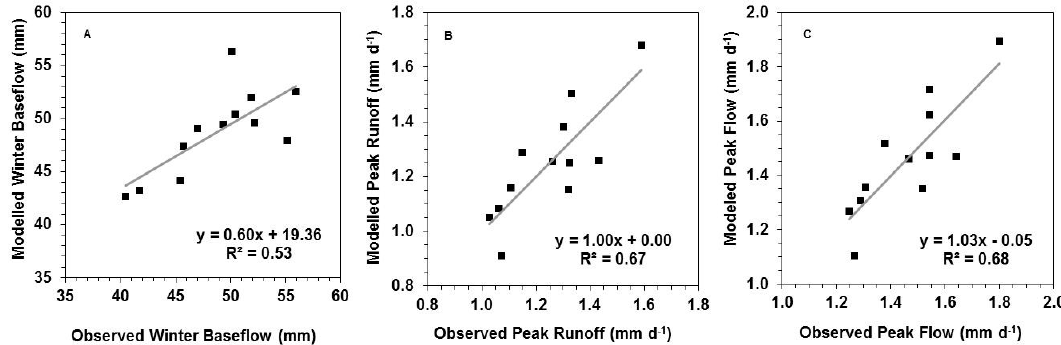
Figure 5. Comparison of model results for the Mackenzie River Basin. ( A ): modeled vs. observed total baseflow in winter; ( B ): modeled vs. observed daily peak surface runoff; ( C ): modeled vs. observed daily peak river flow. Table 2. Snowmelt and peak surface runoff model evaluation.